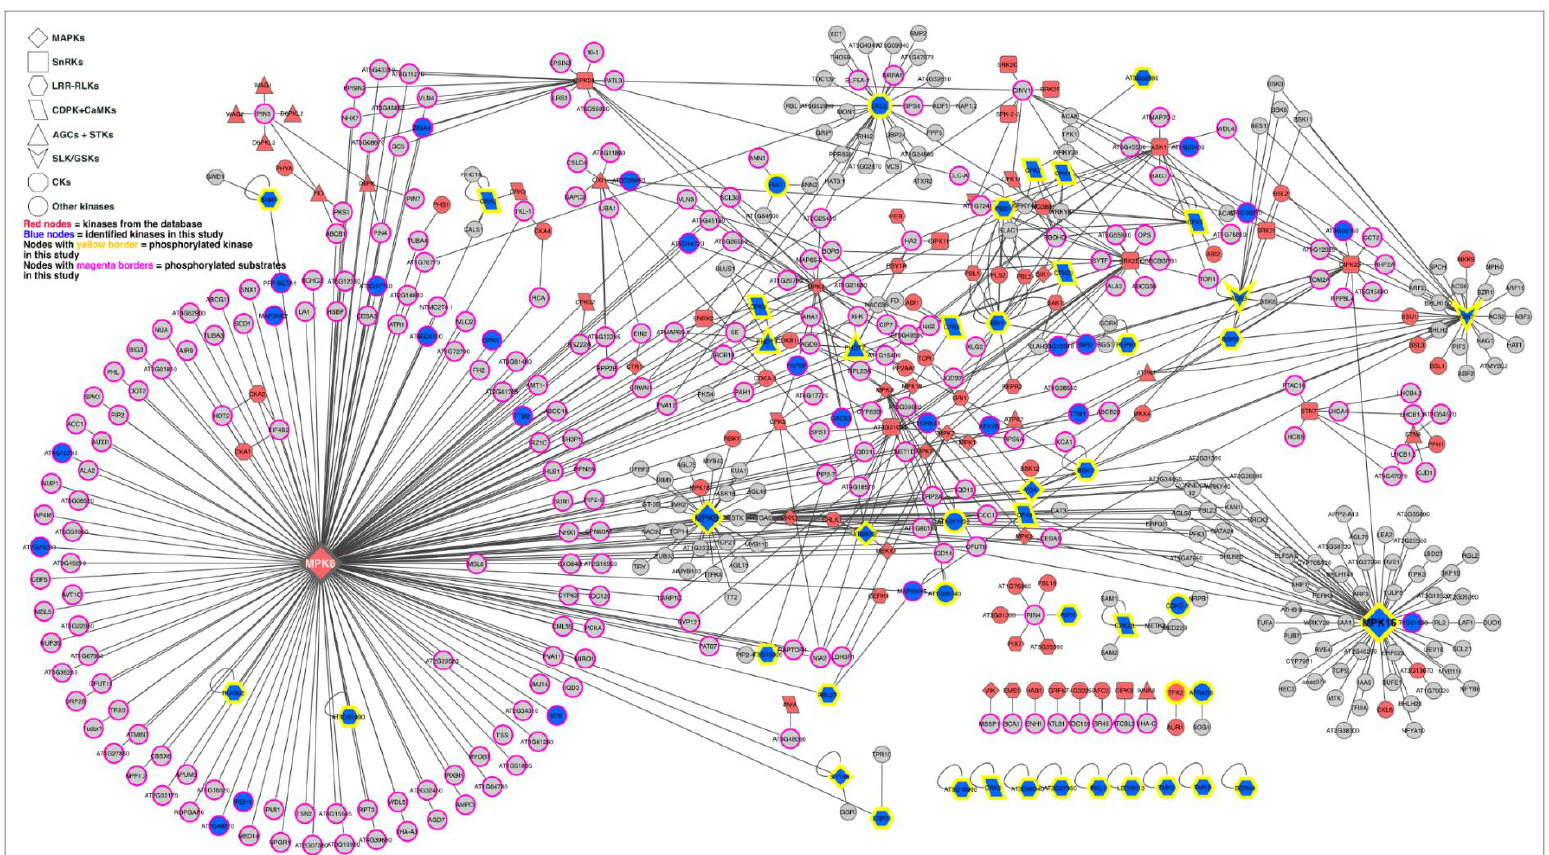
Figure 6. Cold-responsive kinase–substrate network in Arabidopsis thaliana . The network was constructed based on the identified kinase and substrates from this study and their corresponding interactions from the database-derived kinase–substrate interactions. The unique shapes of the nodes in this figure indicate a specific / unique group of kinases involved in the early cold response. Blue nodes indicate the kinases identified in this study; red nodes indicate the upstream kinases of the substrates identified in this study. Yellow and magenta borders indicate the phosphorylated kinases and substrates identified in this study, respectively.